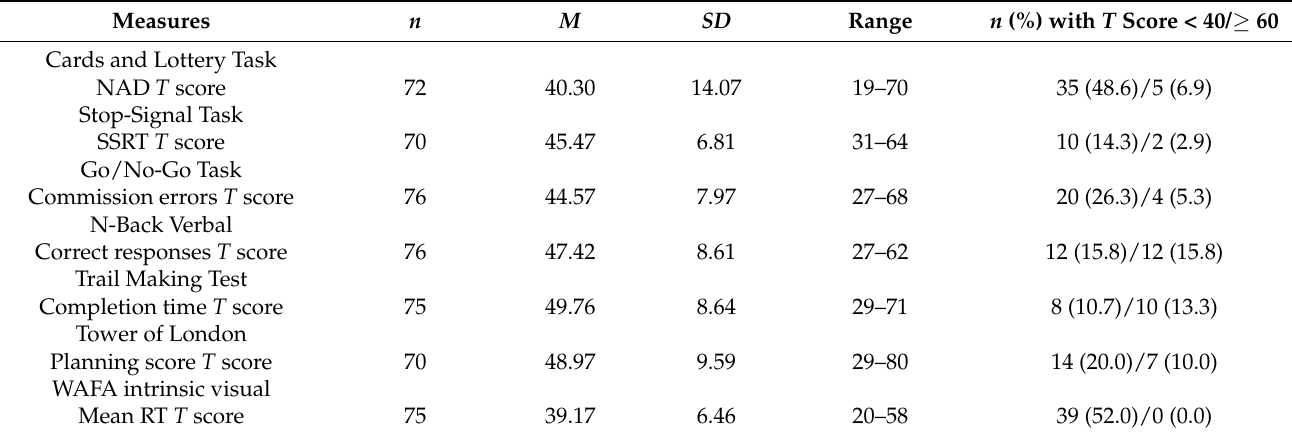
Table 1. EFs in the total sample based on normative